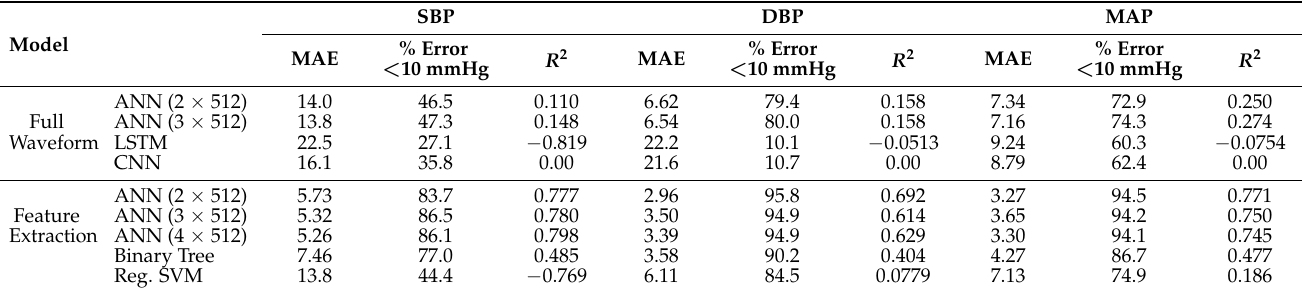
Figure 4. Scatter plot of predicted blood pressure against actual blood pressure for SBP, DBP, and MAP. The models used for the prediction are those that gave the best performance, specifically the 2-layered feature-trained ANN for DBP and MAP and the 4-layered feature-trained ANN for SBP. Table 2. SBP, DBP, and MAP Results from Trained Machine Learning